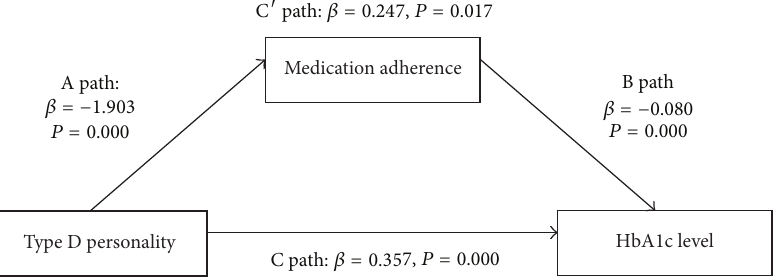
Figure 1: Medication adherence as a mediator between Type D personality and Type D personality after discharge. Note: A path: the independent variable (Type D personality) significantly influences the dependent variable (HbA1c level at T2) in the absence of the mediator (medication adherence). B path: the mediator (medication adherence) has a significant unique effect on the dependent variable (HbA1c level at T2) and also means that the direct effect of medication adherence on the dependent variable (HbA1c level at T2). C path: the independent variable (Type D personality) significantly influences the dependent variable (HbA1c level at T2). C 󸀠 path: the independent variable (Type